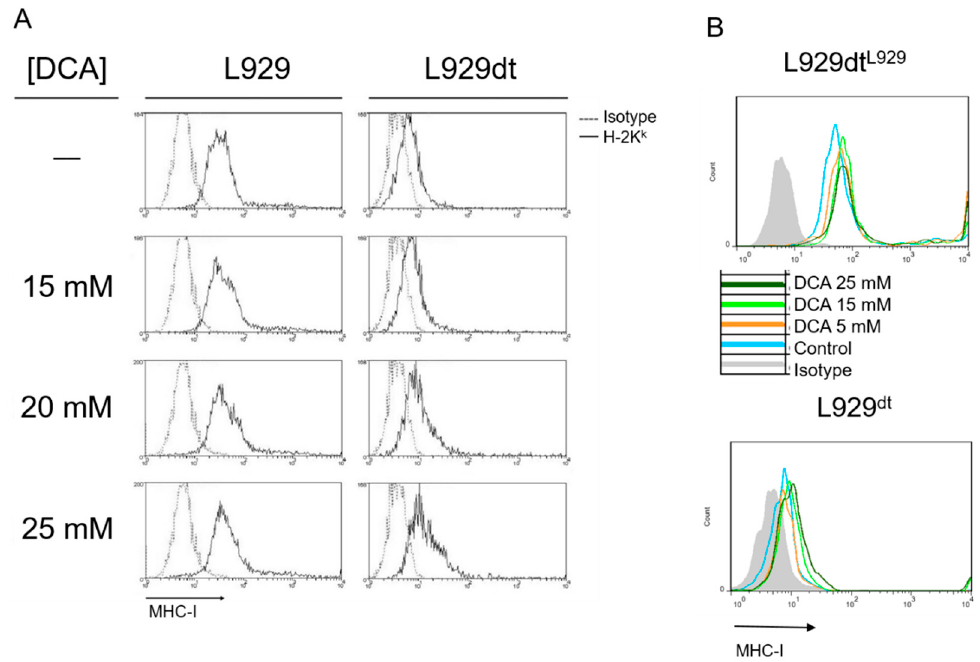
Figure 9. E ff ect of DCA on MHC-I expression. L929 or L929dt ( A ), and L929dt L929 or L929 dt cells ( B ) were supplemented or not (-) during 72 h with the indicated concentrations of DCA and MHC-I expression determined by flow cytometry using a specific anti-H-2K k antibody conjugated with FITC. Dashed or grey histograms, labeling with an irrelevant antibody of the same isotype and conjugated with FITC; solid histograms, labeling with the anti-H2-K k mAb conjugated with FITC. Data are representative of at least three different experiments.